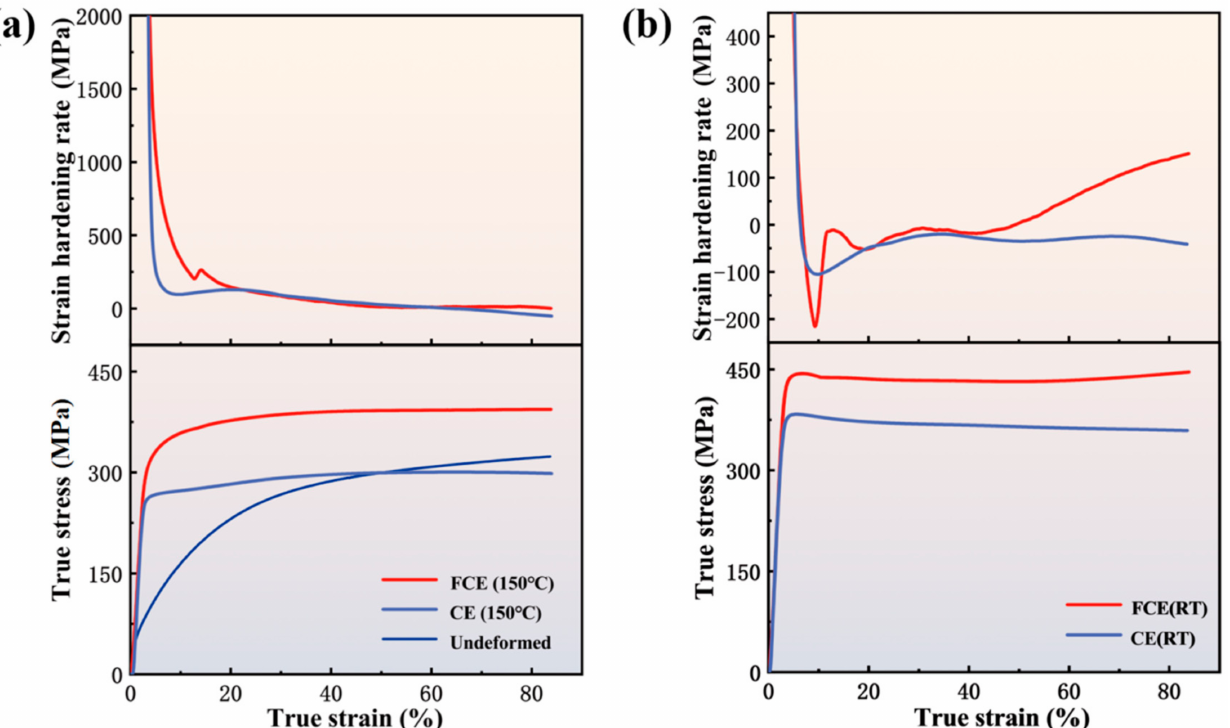
Figure 16. Mechanical properties of unprocessed materials, materials after CE and FCE at room temperature and 150 ◦ C: ( a ) true stress-strain and strain hardening rate curve of unprocessed materials, materials after CE and FCE at 150 ◦ C; ( b ) true stress-strain and strain hardening rate curve of materials after CE and FCE at room